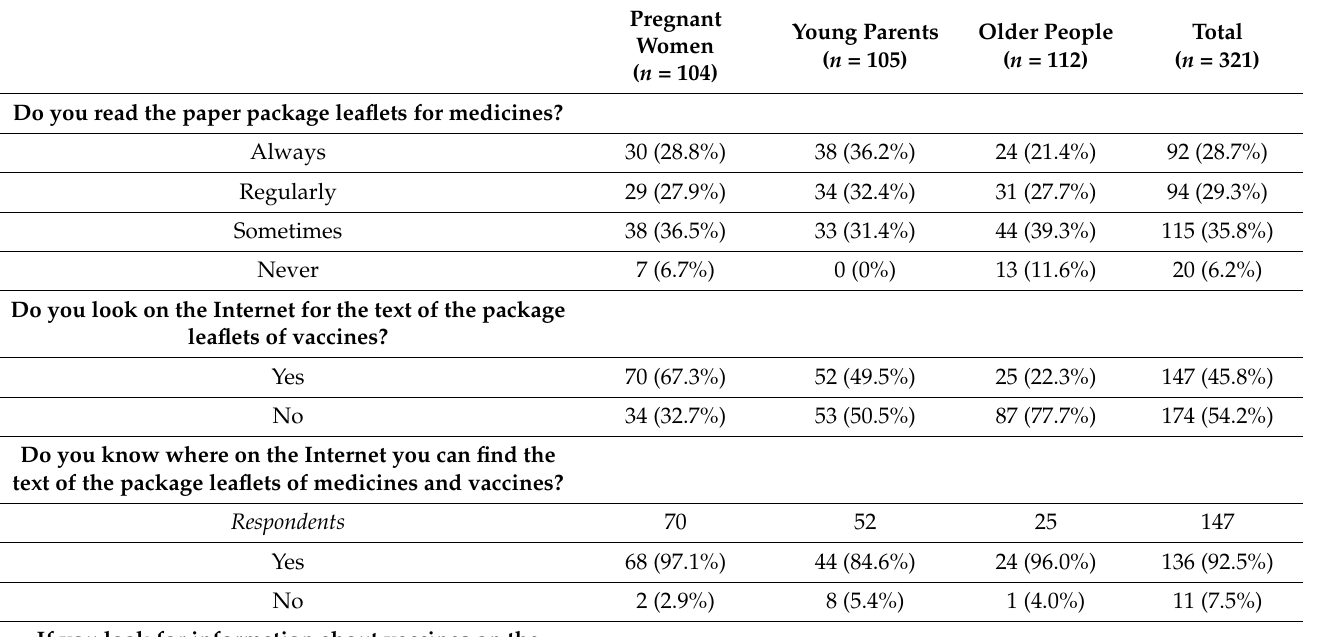
Table 3. Overview of the answers of the respondents about PPLs in general, for the three